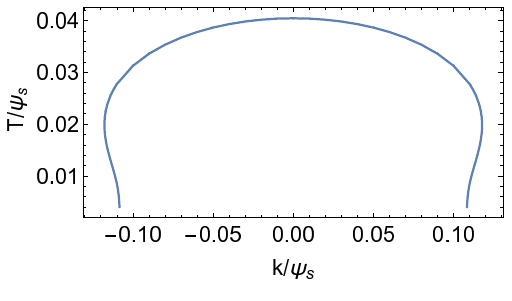
Figure 2 . Plot of the critical as a function of the wavenumber k